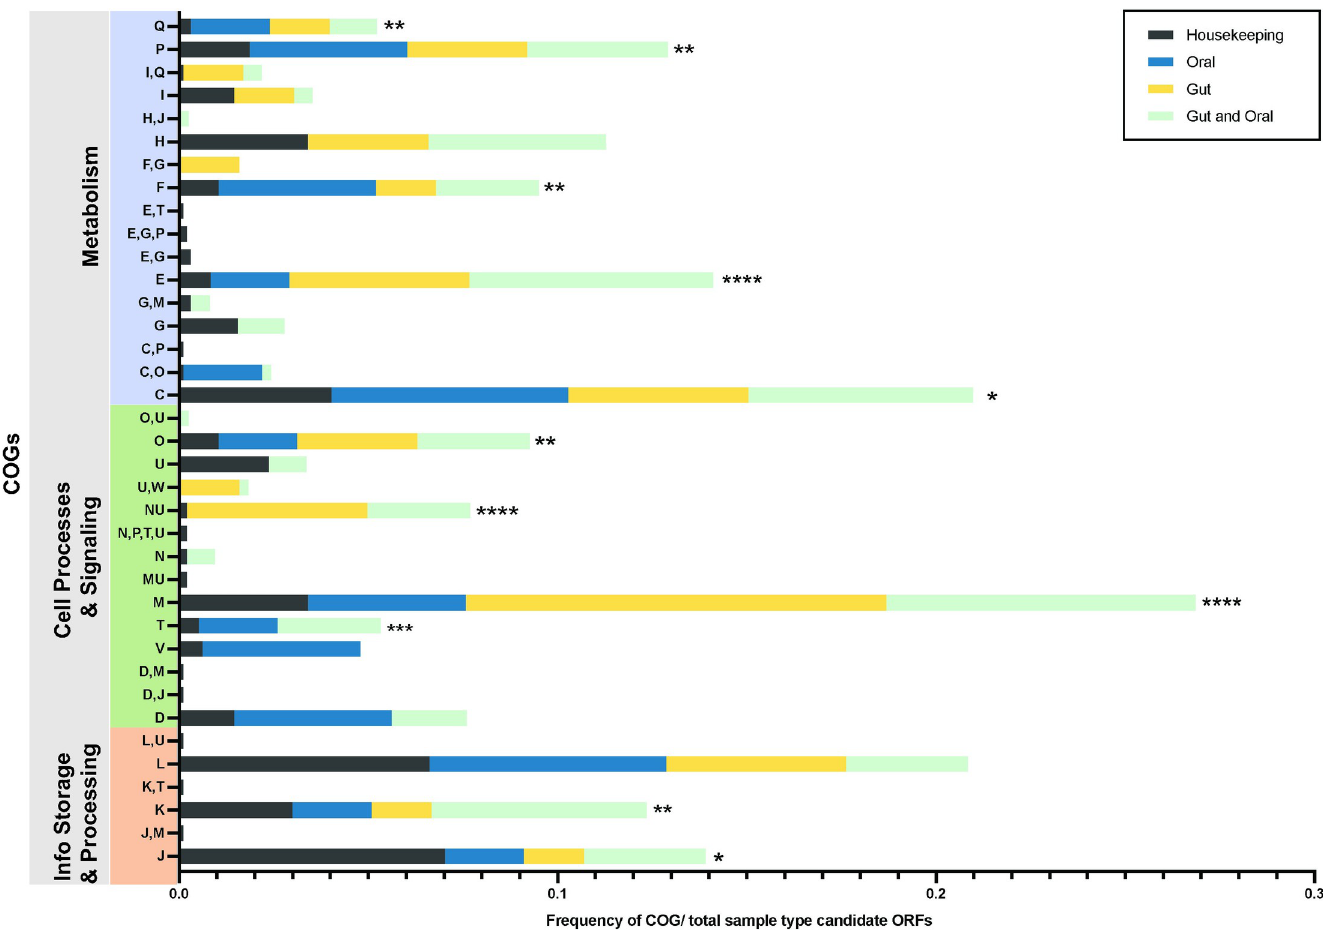
Fig 3. Function-based classification of candidate genes. COG category classification and frequency of candidate genes identified either as required for in vitro growth (housekeeping) or significantly altered in abundance in host passage samples (Gut, Gut and Oral, Oral). Two-sided Fisher’s exact test was used to compare frequency of COGs in the housekeeping pool to their total host site frequency. COG category J was significantly more prevalent in the housekeeping pool, while categories Q,P,F,E, C,O,NU, M,T and K were more prevalent in host sites. Classification was conducted using eggNOG mapper v-2. Bar color indicates sample type. � = p < 0.05, �� = p < 0.01, ��� = p < 0.001, ���� = p < 0.0001. Category definitions are based on the Database of Clusters of Orthologous Genes as follows: J, Translation, Ribosomal Structure and Biogenesis; K, Transcription; L, Replication, Recombination and Repair; B, Chromatin Structure and Dynamics; D, Cell cycle control, cell division and chromosome partitioning; V, Defense Mechanisms; T, Signal Transduction Mechanisms; M, Cell Wall/Membrane/Envelope Biogenesis; N, Cell Motility; W, Extracellular Structures; U, Intracellular Trafficking, Secretion, and Vesicular Transport; O, Posttranslational Modification, Protein Turnover, Chaperones; C, Energy Production and Conversion; G, Carbohydrate Transport and Metabolism; E, Amino Acid Transport and Metabolism; F, Nucleotide Transport and Metabolism; H, Coenzyme Transport and Metabolism; I, Lipid Transport and Metabolism; P, Inorganic Ion Transport and Metabolism; Q, Secondary Metabolite Biosynthesis, Transport and Catabolism. Genes without an assigned COG or in category S (function unknown) were omitted from this analysis.